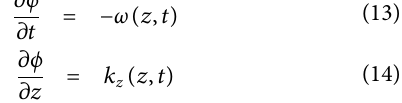
Frontiers in Astronomy and Space Sciences |